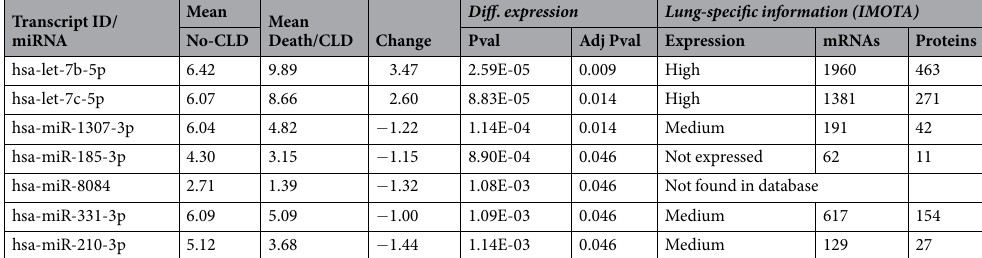
Table 2. Differentially expressed miRNAs in blood of CDH children with poor outcome at 28 days after birth. * Only miRNAs with Adj Pval < 0.05 from a moderated t-test and expression change ≥ 1 were considered differentially expressed. Blood samples were drawn at a 24 h after birth time-point. CLD: chronic lung disease. Death refers to intra-hospital death between 24 h and 28 days after